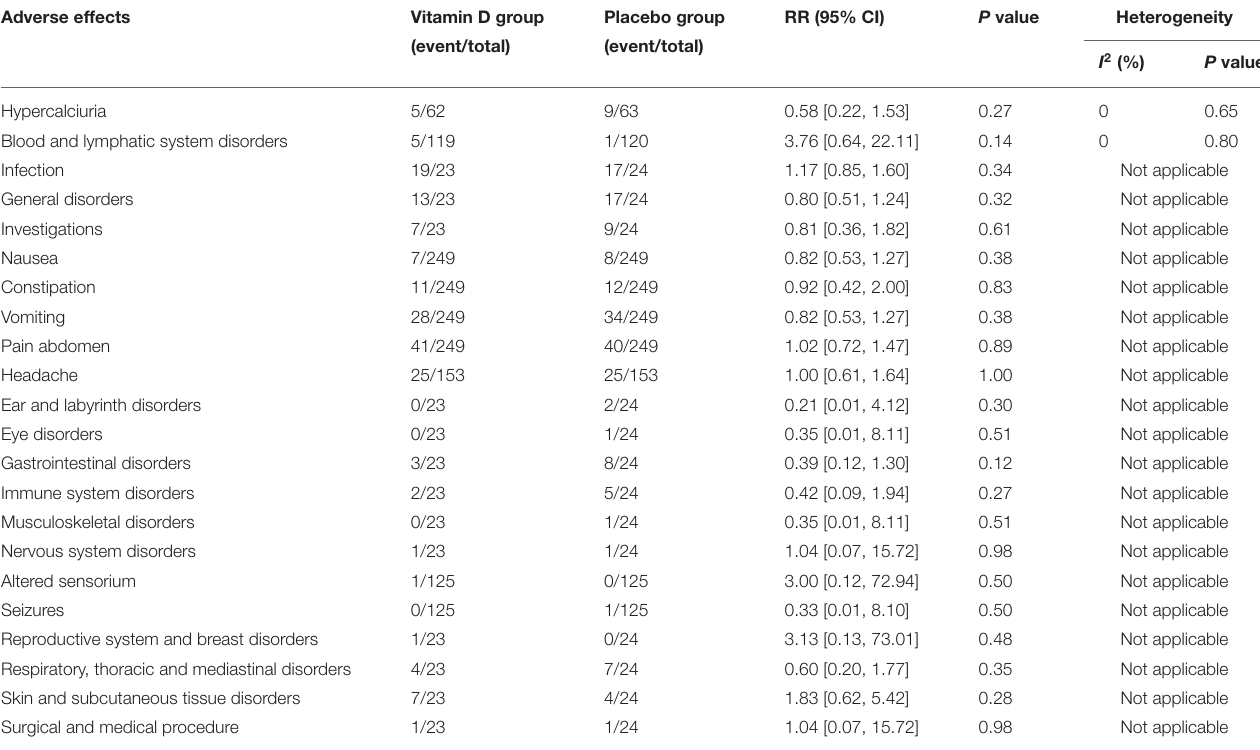
TABLE 2 | Adverse effects (all grade) associated with vitamin D vs.